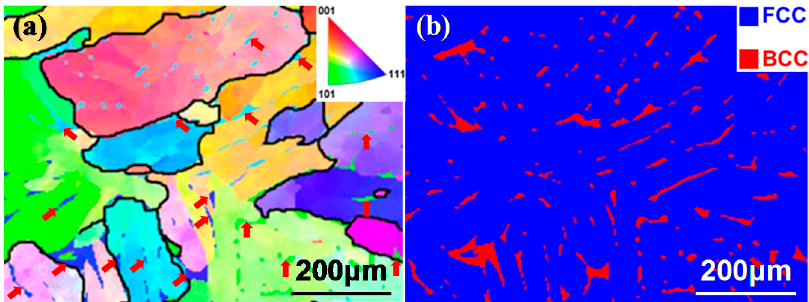
Figure 2. ( a ) Electron backscatter diffraction (EBSD) orientation map, with the insert showing the orientation of each grain; ( b ) phase map of the studied steel.